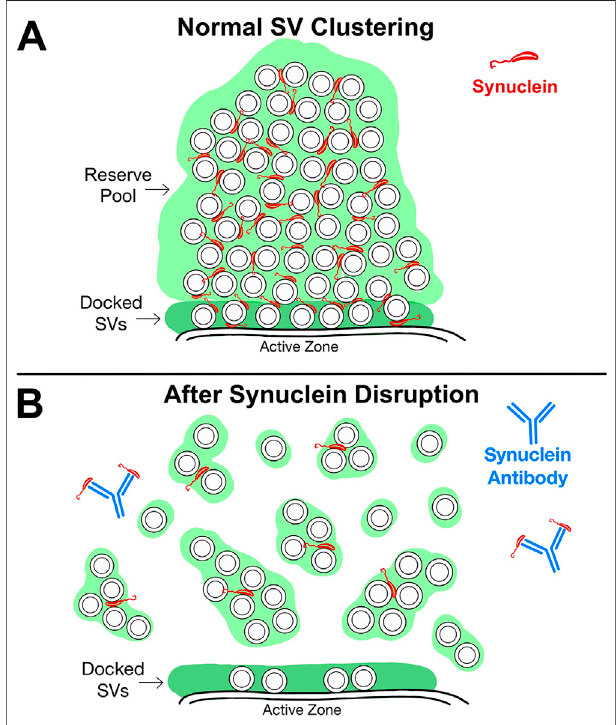
FIGURE 6 | Working model for synuclein ’ s role in SV clustering. (A) At resting, intact synapses, synuclein is localized to the SV clusters. The distal reserve pool of SVs is denoted by the light green region, and the pool of docked SVs is denoted by the dark green region. (B) After synuclein disruption using the pan-synuclein antibody, SVs in the distal reserve pool disperse into smaller subclusters, as well as individual SVs. The remaining SV subclusters may be held together via synapsin-mediated LLPS or some other scaffolding mechanism involving protein tethers. After synuclein disruption, SVs nearest the active zone are also depleted,indicatinga rolefor synuclein in SV